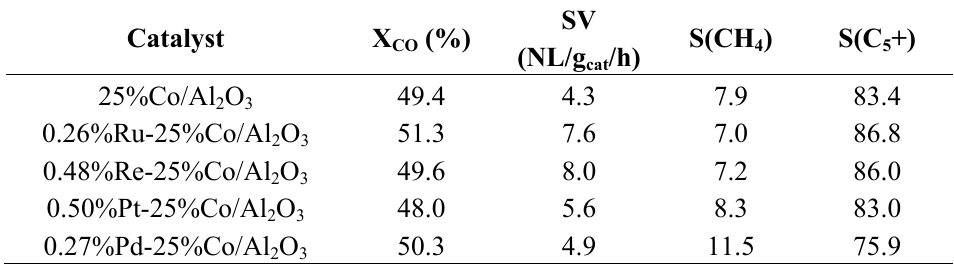
Table 5. Product selectivities * for 25%Co/Al promoters (Pt, Re, Ru) or Pd at X Conditions: 220 °C, 2.2 MPa, H 2012, Elsevier).